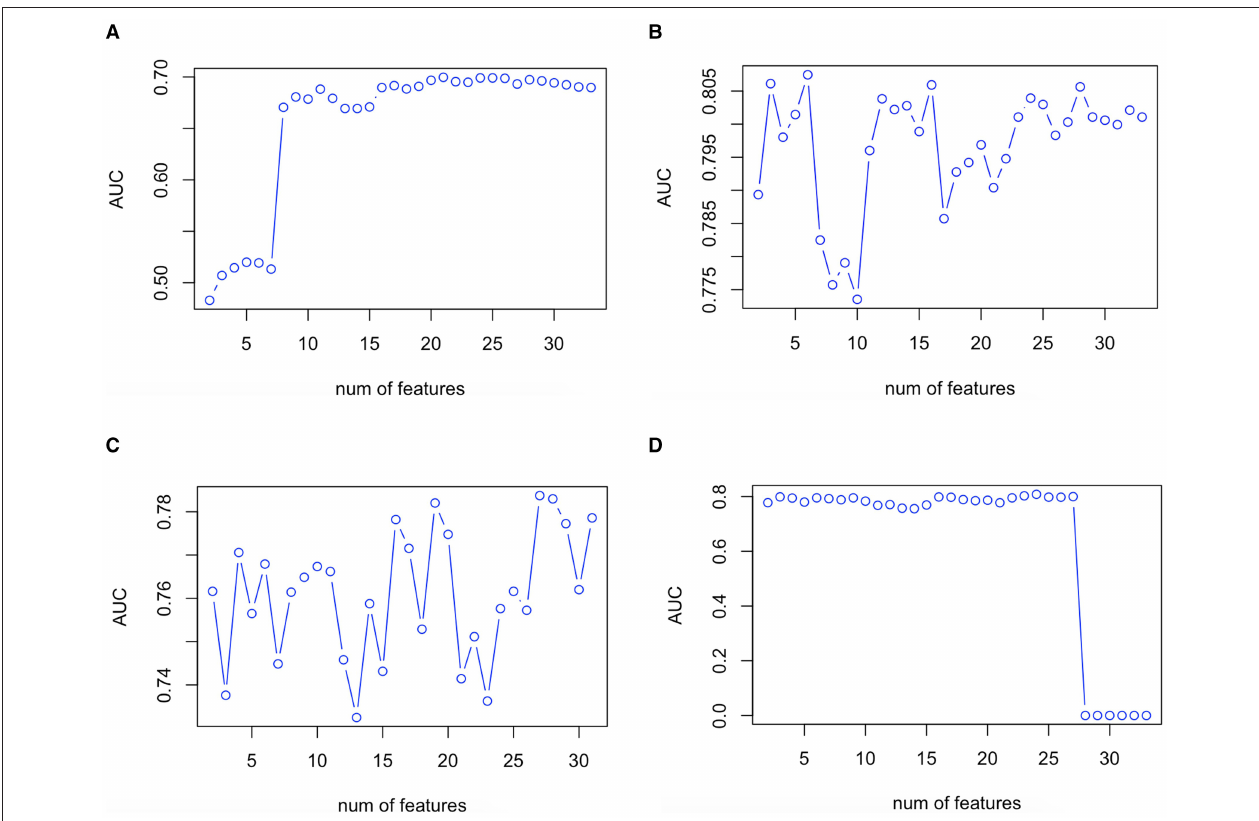
FIGURE 2 | Validation plot of feature selection in the LR (A) , RF (B) , XGboost (C) , and ANN (D) models. First spot starts in two features. ANN, artificial neural network; AUC, area under the receiver operating characteristic curve; LR, logistic regression; RF, random forest; XGboost, eXtreme Gradient Boosting.